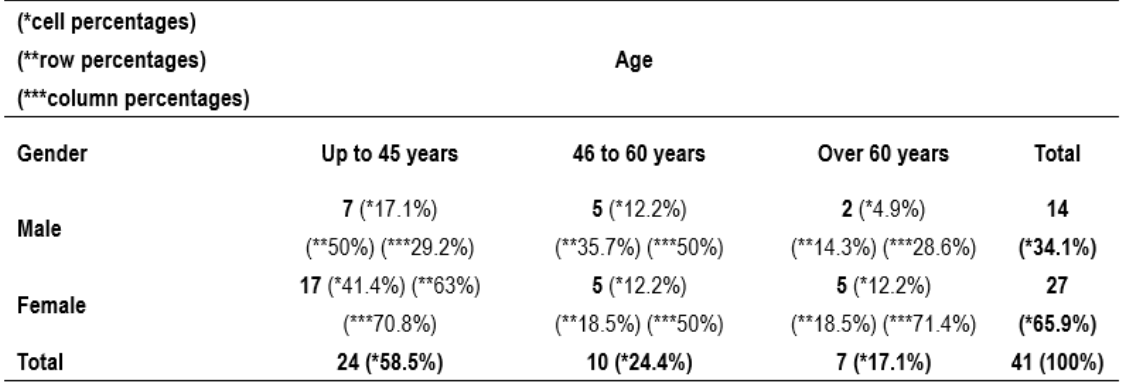
Teachers Sample